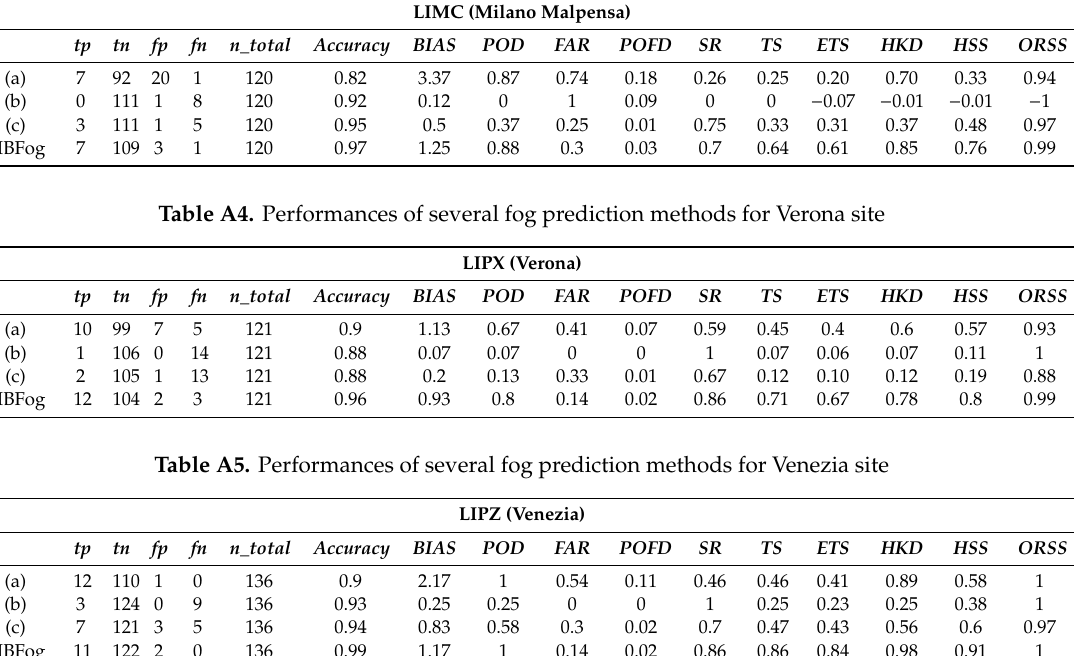
Table A3. Performances of several fog prediction methods for Milano Malpensa site LIMC (Milano Malpensa)